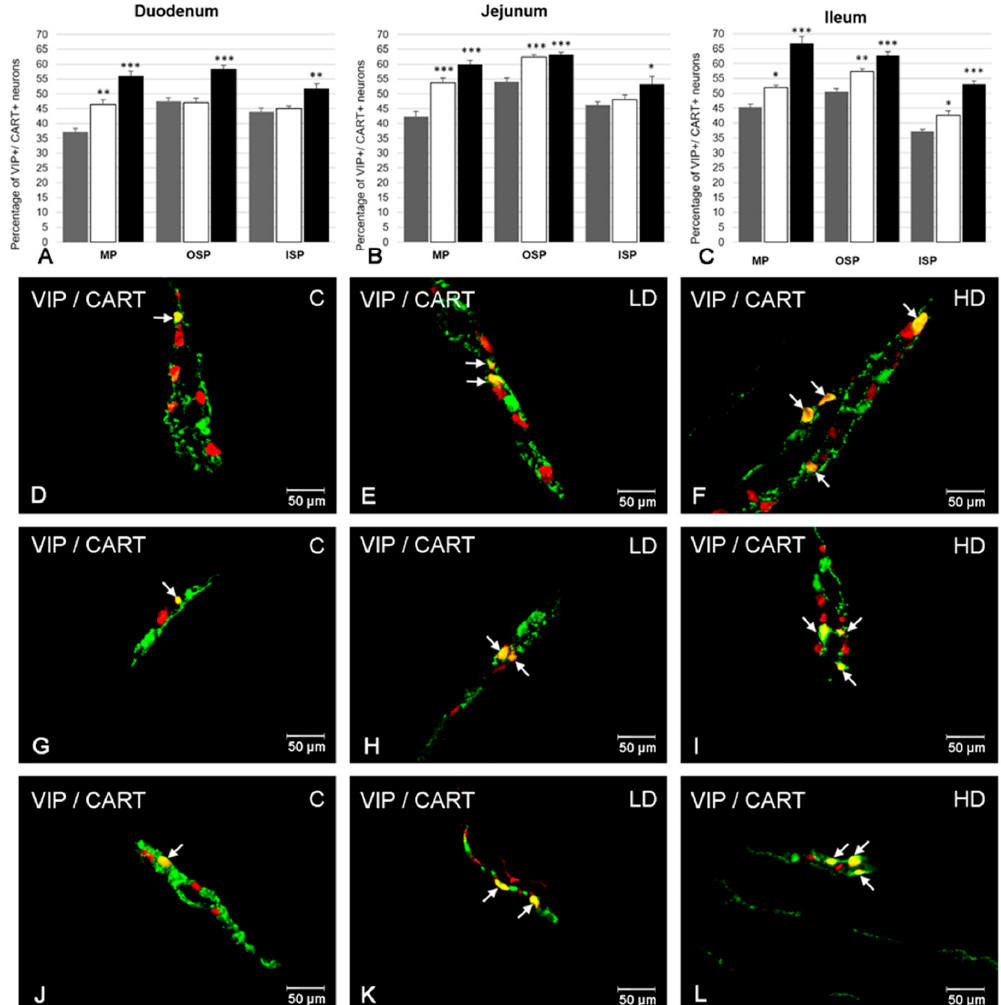
Figure 4. The ratio of co-localization of VIP with CART in intramural neurons in each part of the porcine small intestine (duodenum, jejunum, and ileum) in control animals (grey bars), after low (white bars) and high dose (black bars) of acrylamide supplementation (A – C) and the most representative images showing VIP-LI neurons simultaneously immunoreactive to CART in animals from control (D,G,J), LD (E,H,K), HD (F,I,L) group. ( A ) Mean (± SEM) percentage of VIP+/CART+ neurons in the myenteric plexus (MP), outer submucous plexus (OSP), and inner submucous plexus (ISP) within the porcine duodenum; ( B ) Mean (± SEM) percentage of VIP+/CART+ neurons in the myenteric plexus (MP), outer submucous plexus (OSP), and inner submucous plexus (ISP) within the porcine jejunum; ( C ) Mean (± SEM) percentage of VIP+/CART+ neurons in the myenteric plexus (MP), outer submucous plexus (OSP), and inner submucous plexus (ISP) within the porcine ileum; ( D ) VIP+/CART+ neurons in the myenteric plexus of the porcine duodenum in animals from control group; ( E ) VIP+/CART+ neurons in the myenteric plexus of the porcine duodenum in animals from LD group; ( F ) VIP+/CART+ neurons in the myenteric plexus of the porcine duodenum in animals from HD group; ( G ) VIP+/CART+ neurons in the outer submucous plexus (OSP) of the porcine jejunum in animals from control group; ( H ) VIP+/CART+ neurons in the outer submucous plexus (OSP) of the porcine jejunum in animals from LD group; ( I ) VIP+/CART+ neurons in the outer submucous plexus (OSP) of the porcine jejunum in animals from HD group; ( J ) VIP+/CART+ neurons in the inner submucous plexus (ISP) of the porcine ileum in animals from control group; ( K ) VIP+/CART+ neurons in the inner submucous plexus (ISP) of the porcine ileum in animals from LD